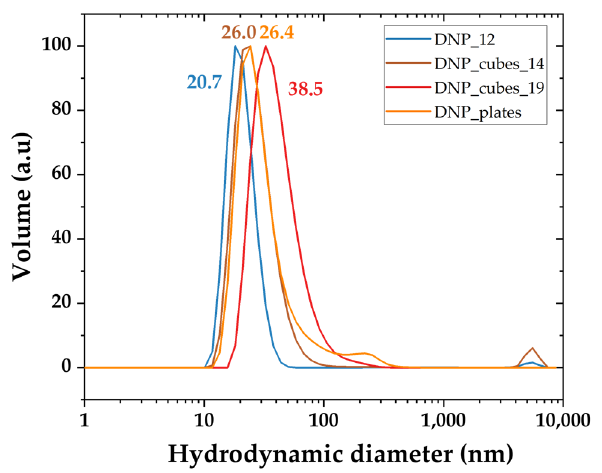
Figure 4. Hydrodynamic size distribution in volume of all DNPs measured by DLS. Table 4. Mean hydrodynamic diameter and relaxivity values of selected batches of DNPs measured at 60 MHz and 1.41 T, compared with Resovist, a commercial T 2 contrast agent for MRI.